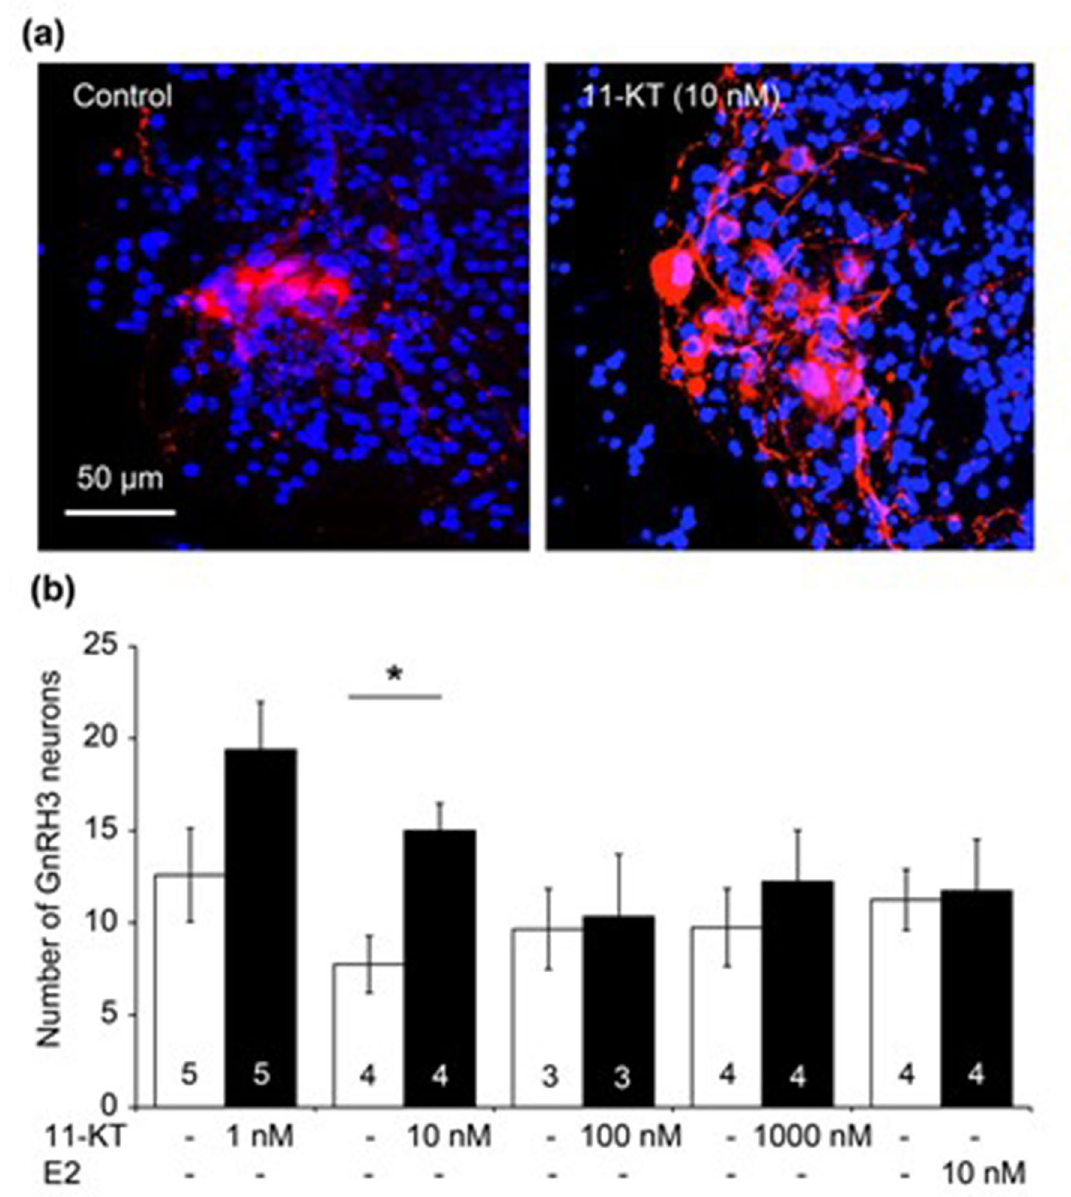
Figure 2. ( a ) Representative images of immunocytochemistry with gonadotropin-releasing hormone 3 (GnRH3) antibody. GnRH3 neurons (red) in control (left) and 11-ketotestosterone (11-KT)-treated (right) brain slices. Cell nuclei (blue) were stained with Hoechst 33342. ( b ) The numbers of GnRH neurons. White and black bars indicate the numbers of GnRH3 neurons in control slices and those treated with 11-KT (1, 10, 100 and 1000 nM ) and E2 (10 nM) (scale bar, 50 μm). An asterisk indicates a significant difference at p <0.05 (paired Student t -test). Numerals in bars indicate the numbers of animals used for preparing brain slices. Data are expressed as the mean ± standard error of the